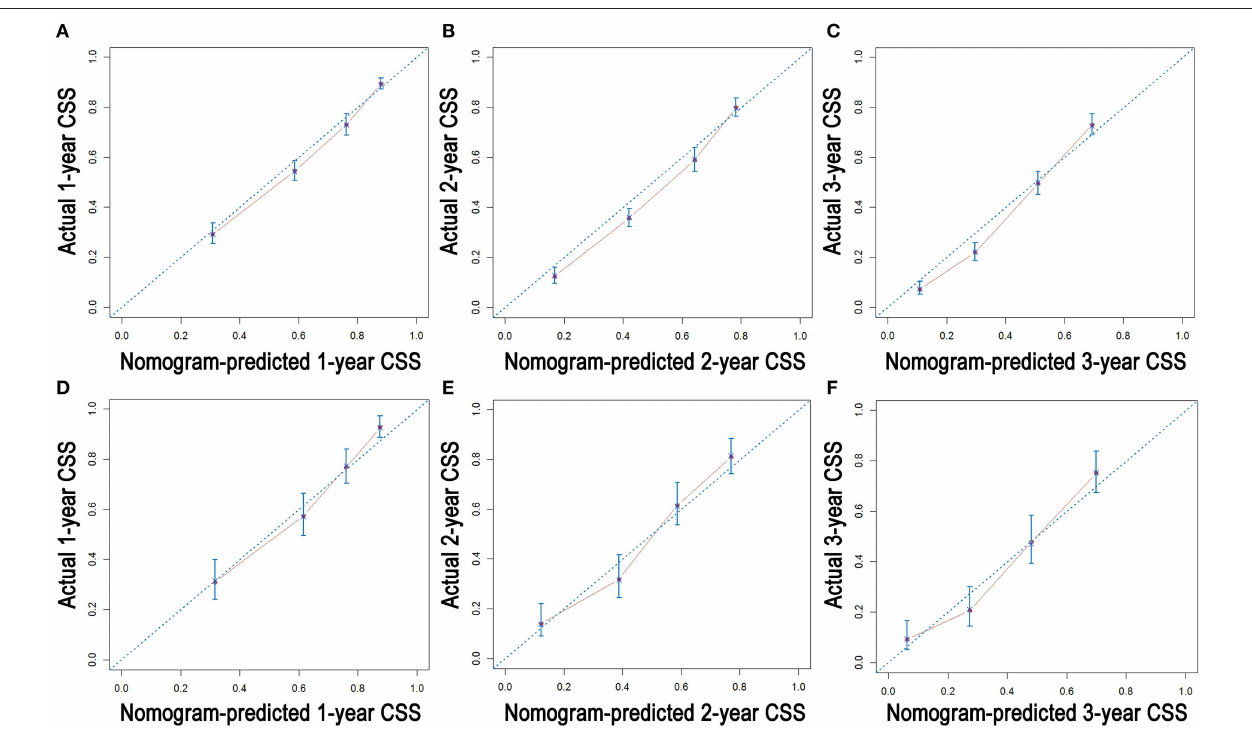
Frontiers in Oncology |